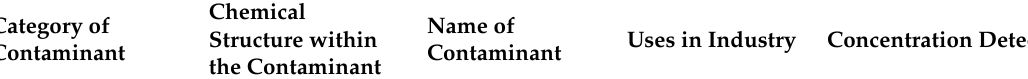
Table 1. Global occurrence of CECs and their use in the